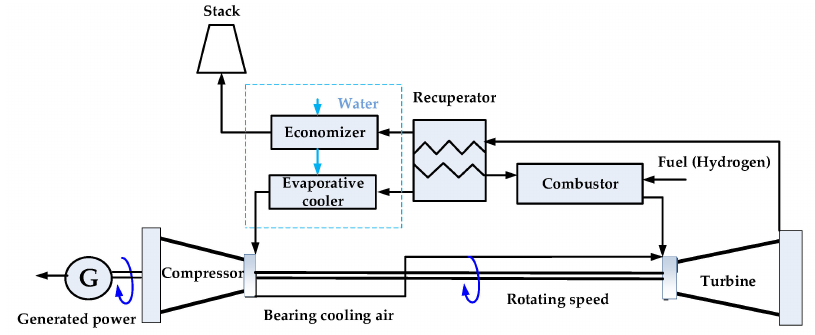
Figure 6. Schematic diagram of micro-gas turbine [2].